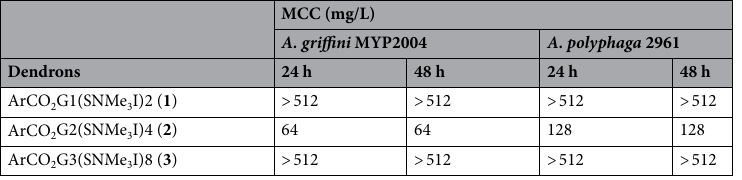
Table 3. MCC (mg/L) in A. griffini MYP2004 and A. polyphaga 2961 after 24 and 48 h of treatment of dendron treatment